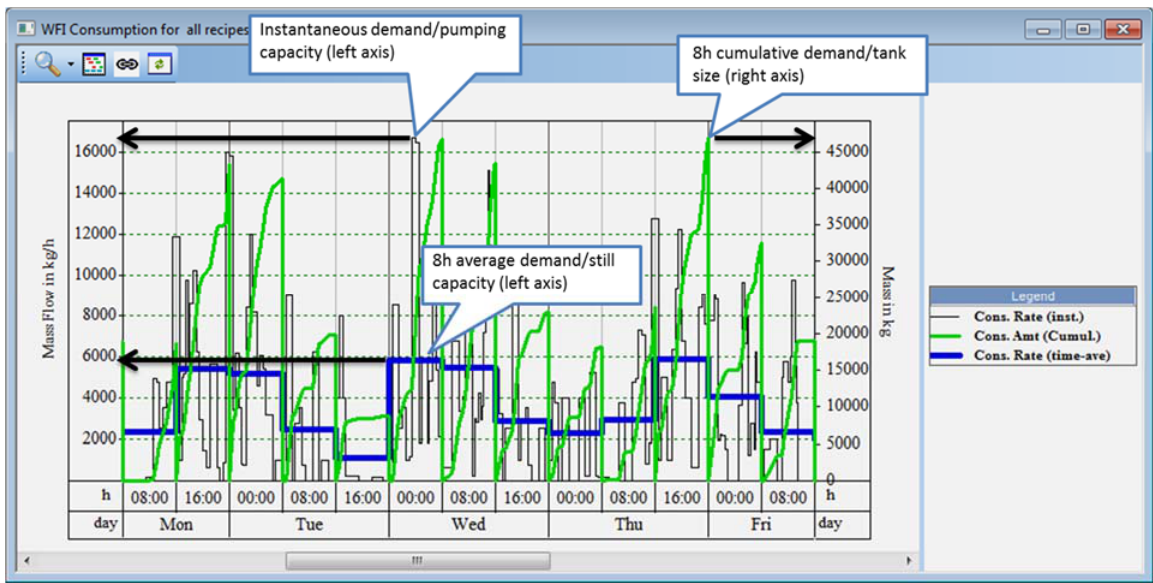
Figure 13. Water For Injection (WFI) demand chart for utility